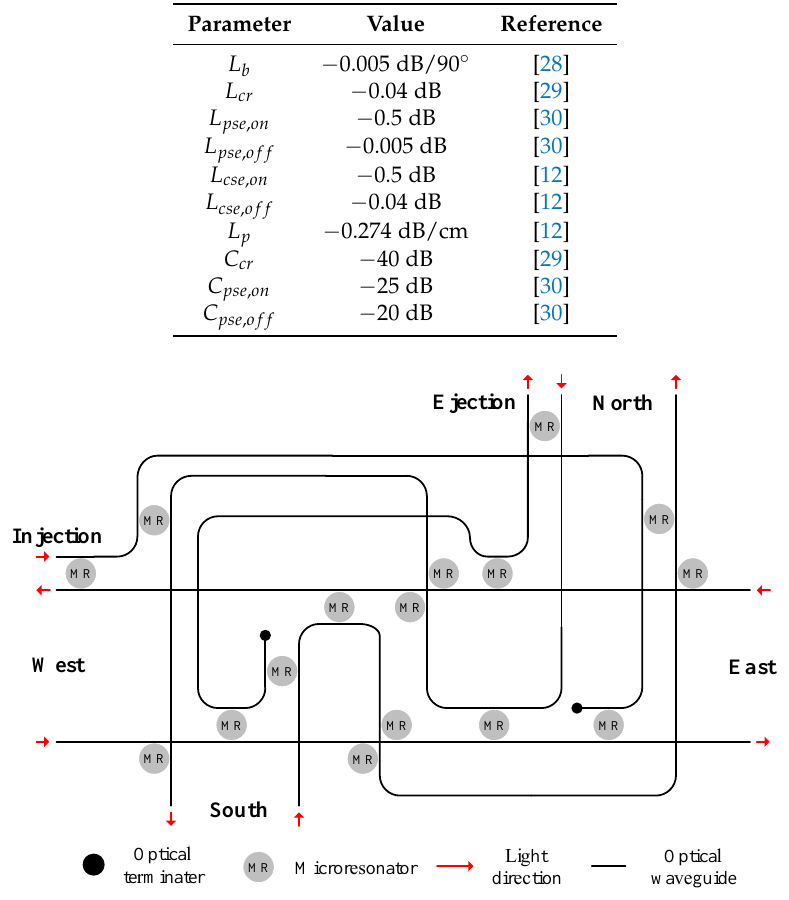
Table 1. The loss values and crosstalk coefficients.